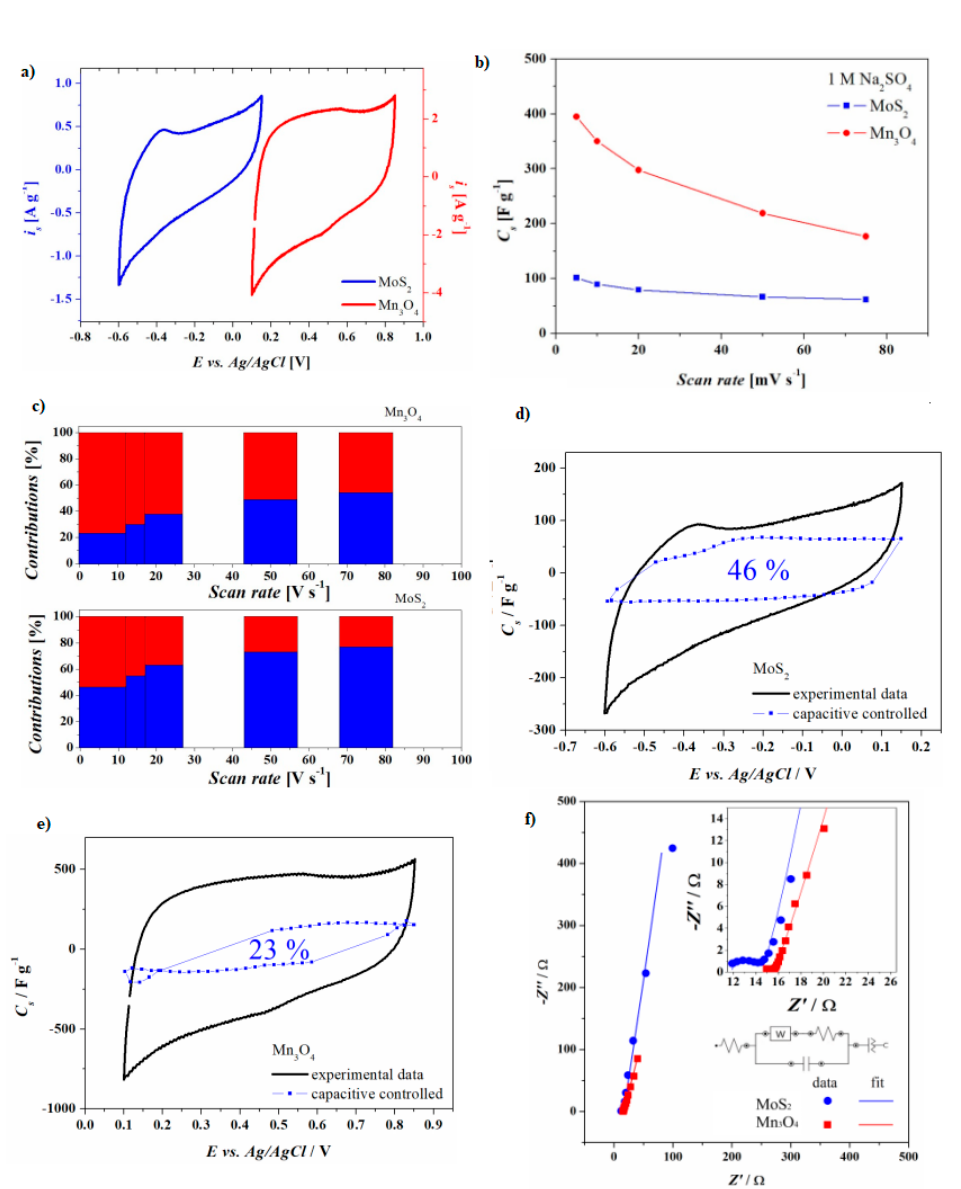
Figure 4. Comparison of cyclic voltammetry ( a ), comparison of specific capacitances of MoS 2 (blue graphs, 0.85 mg) and Mn 3 O 4 (red graphs, 0.4 mg) electrodes ( b ). Estimation of the charge stored by diffusion-controlled phenomena (red) and capacitive controlled phenomena (blue) at different scan rates on MoS 2 (lower graph) and Mn 3 O 4 (upper graph) electrodes ( c ), comparison of experimental data with computed data for MoS 2 and Mn 3 O 4 electrodes, respectively ( d , e ), AC impedance spectroscopy and Nyquist plot up to 10 mHz of the MoS 2 electrode (blue) and Mn 3 O 4 electrodes red ( f ), inset shows the equivalent circuit of electrode, respectively.